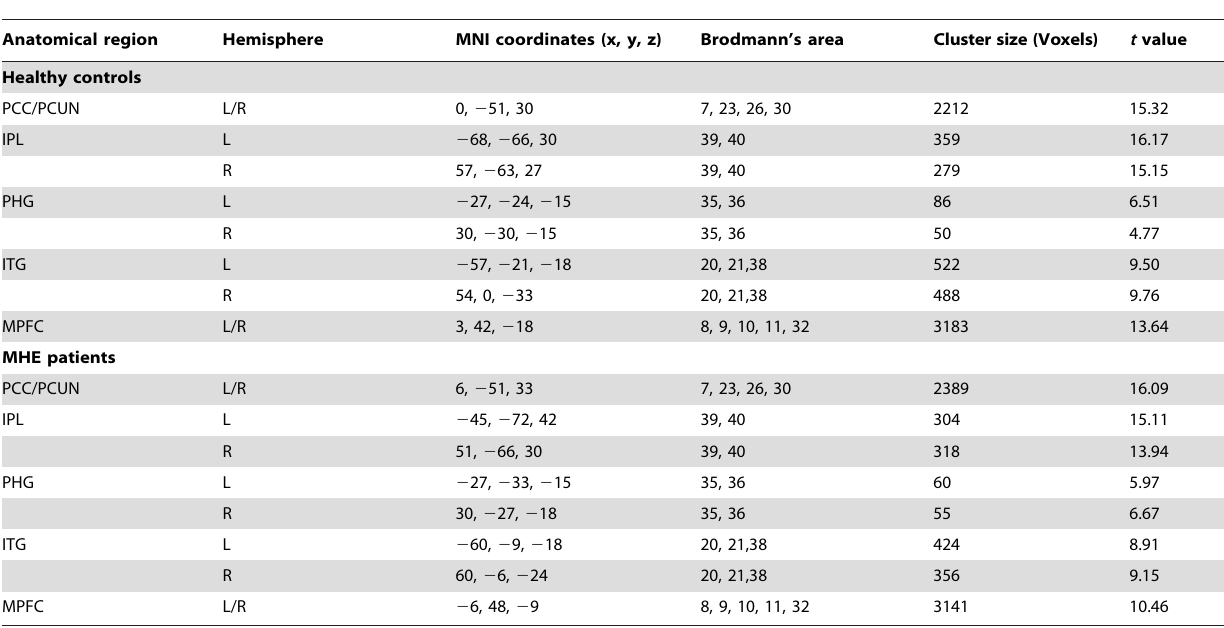
Table 2. Details on the brain regions in the DMN map (P , 0.01, FDR corrected) from the healthy controls and MHE patients.